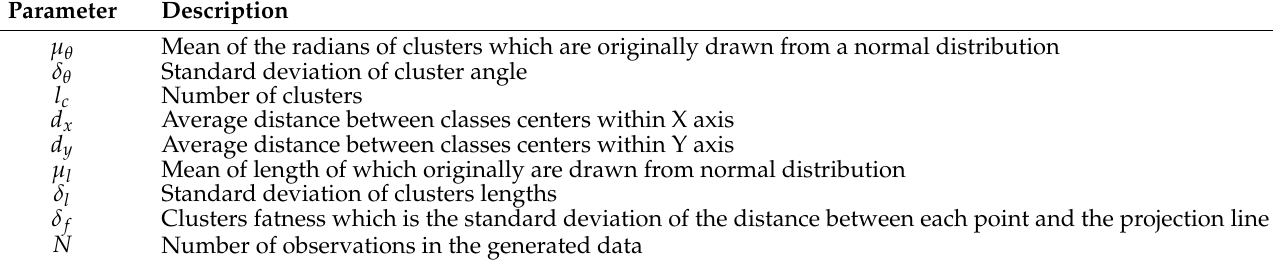
Table 2. Main parameter description of dataset generator.